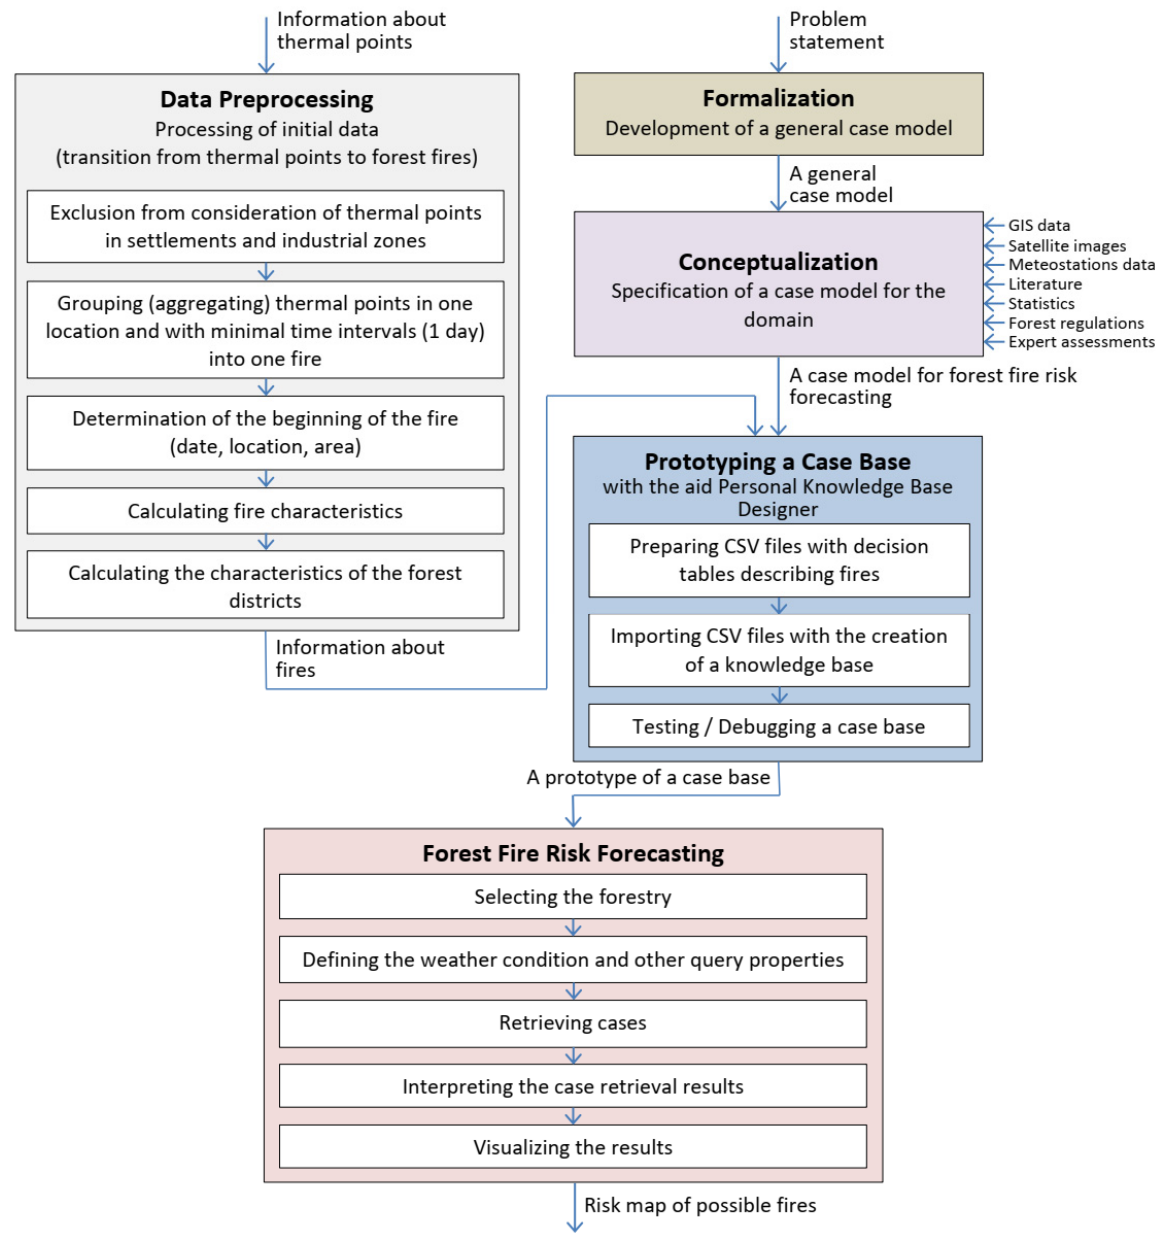
Figure 4. The main stages and steps of our research.